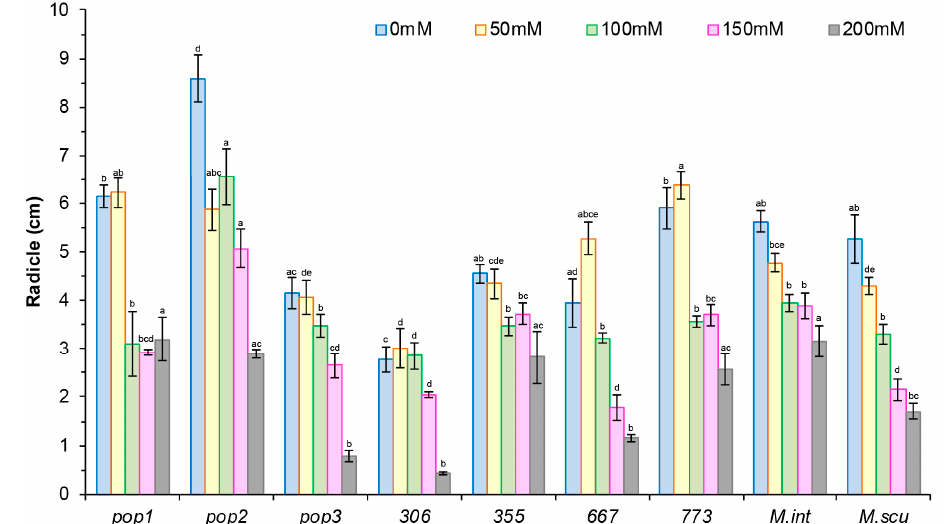
Figure 4. Effect of different concentrations of salt stress (0, 50, 100, 150, 200 mM NaCl) on radicle length (cm) of seven populations of M. ciliaris ( Pop1, Pop2, Pop3, 306, 355, 667, 773 ), compared to one population of M. intertexta ( M. int ) and one population of M. scutellata ( M. scut ). The means are averages of 25 plants (5 plants/n=5 repetitions for each salt treatment). The standard deviation annotated by different lower-case letters in the same stress type indicate significant differences at p < 0.05, Tukey’s post hoc test.